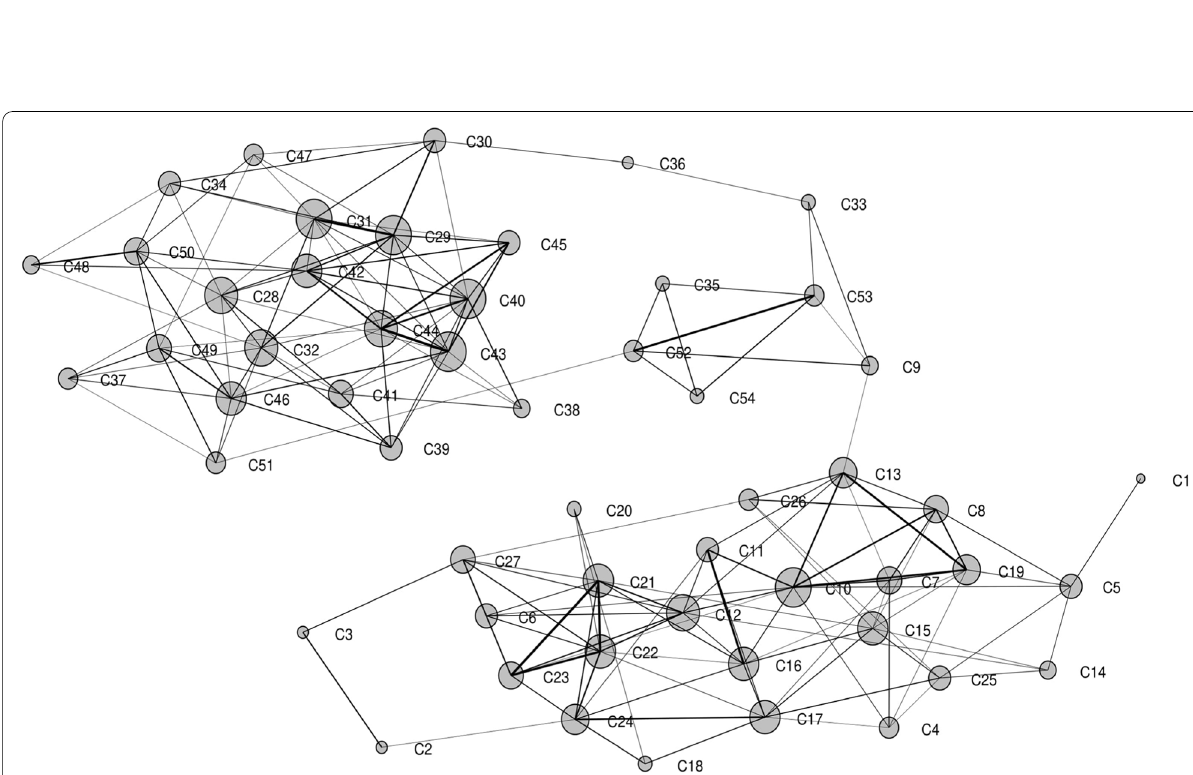
Fig. 7 Representation of correlation analysis with Fruchterman-Reingold algorithm among 54 different Capsicum